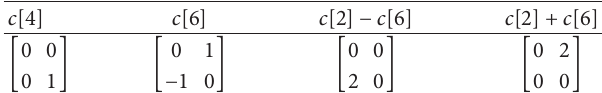
Table 2: 2D AI encoding of Arai DCT